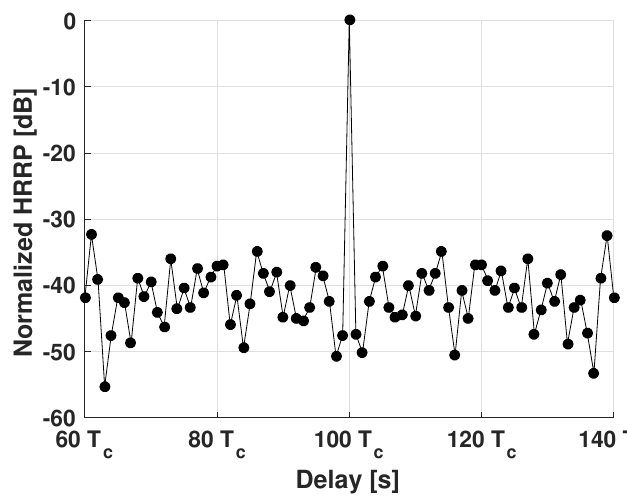
Figure 7. Detail of the range profile obtained for the test described in Section 4.1. It was normalized to the peak, placed at bin #100.